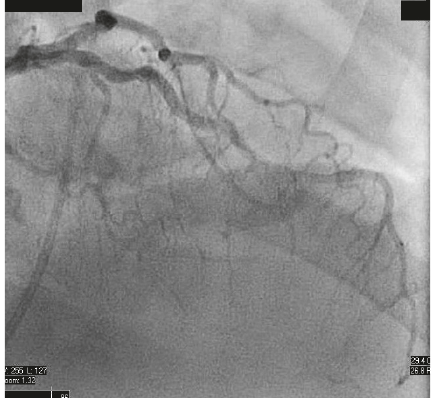
Figure 5: Cardiac MRI. 5.4 × 4.1 × 4.9 cm pseudoaneurysm arising fromthemid-apicalfreewalloftherightventricle,witha9 mmneck (red arrow). There is an adjacent muscular ventricular septal defect, which is likely